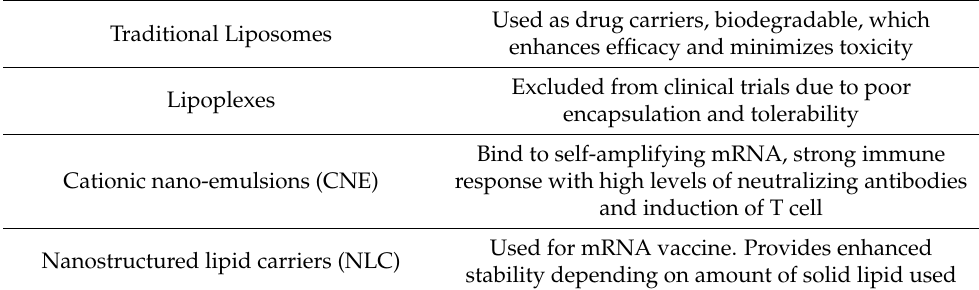
Table 1. Lipid-based formulations for nucleic acid delivery [33]. Traditional